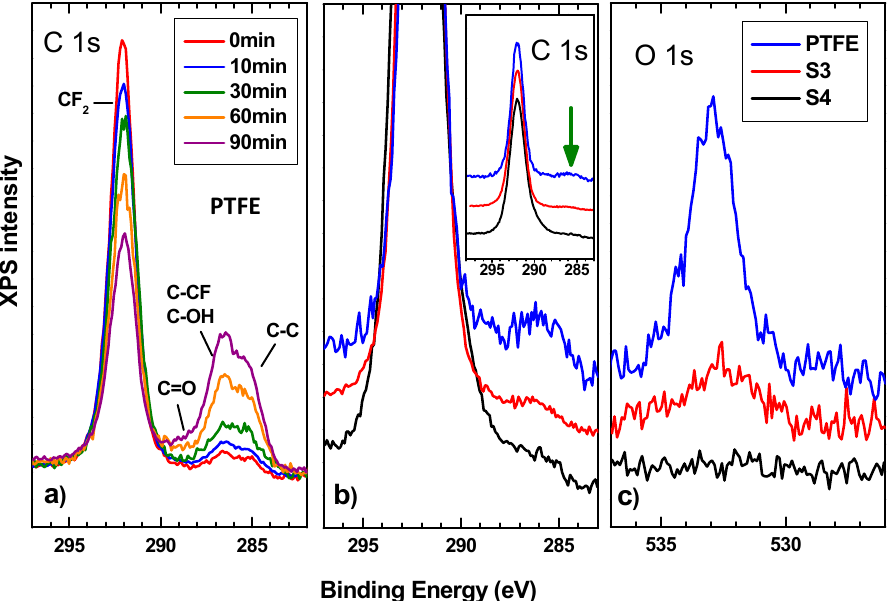
Figure 5. ( a ) XPS spectra of the C 1s corresponding to the PTFE reference sample for different irradiation times. ( b ) Right: XPS spectra of the C 1s corresponding to the PTFE, S3, and S4 samples together. Left: Zoom in to emphasize spectra differences. Spectra were normalized to the maximum intensity to highlight line shape differences, which provides direct valuable insight regarding the chemical environment of C atoms. ( c ) XPS spectra of the O 1s corresponding to the PTFE, S3 and S4 samples together.